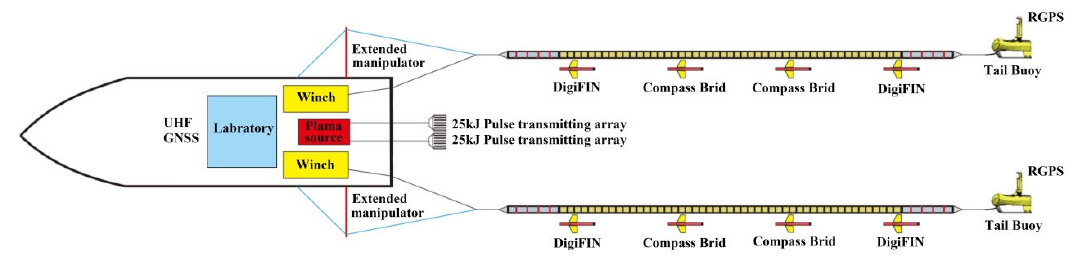
Figure 5. Design of the high-resolution 3D seismic detection system. Table 2. Acquisition parameters for high-resolution seismic acquisition experiment.